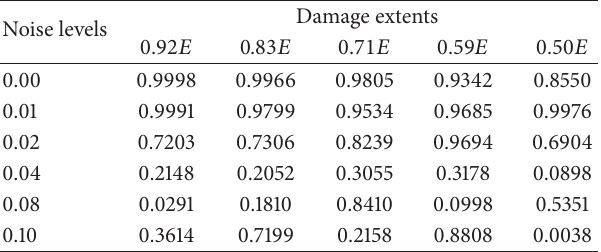
Table 13: The MAC values of multiscale damage parameter vector extracted from the same load case.